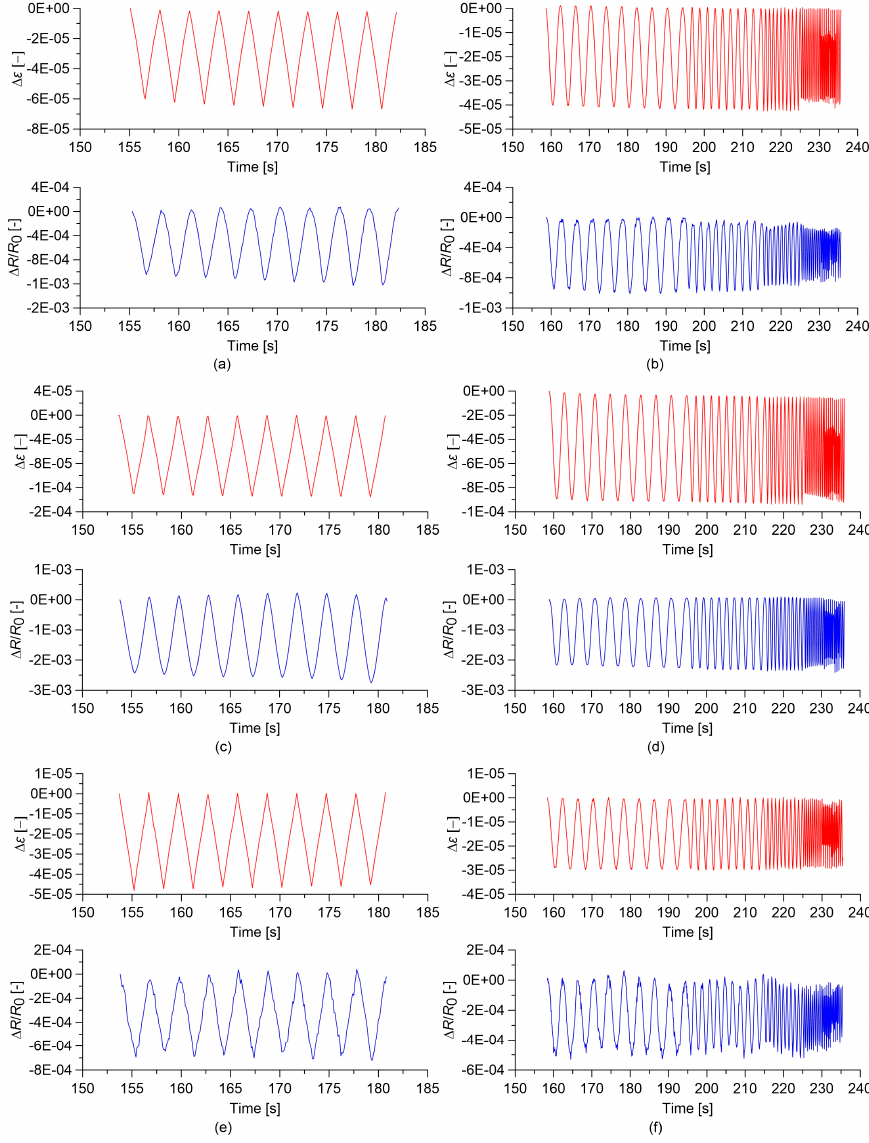
Figure 8. Time histories of the relative change in electrical resistance, Δ R/R 0 , and of the applied strain, Δ ε , obtained from the electromechanical tests. In the plots, R 0 is the electrical resistance value with a preload of 0.5 kN: ( a ) Quasi-static load applied on cured paste with 0.00% MWCNTs; ( b ) Sine-sweep dynamic load applied on cured paste with 0.00% MWCNTs; ( c ) Quasi-static load applied on cured paste with 0.50% MWCNTs; ( d ) Sine-sweep dynamic load applied on cured paste with 0.50% MWCTs; ( e ) Quasi-static load applied on cured paste with 1.50% MWCNTs; ( f ) Sine-sweep dynamic load applied on cured paste with 1.50%